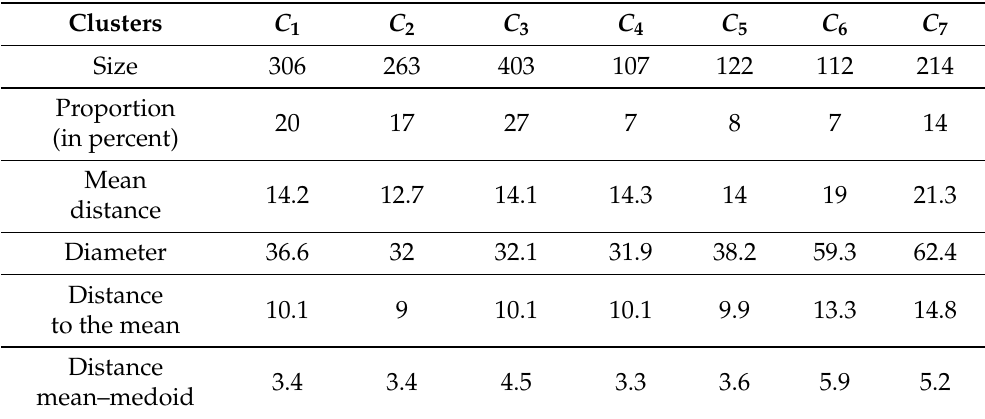
Table 4. Clustering of female body shapes.